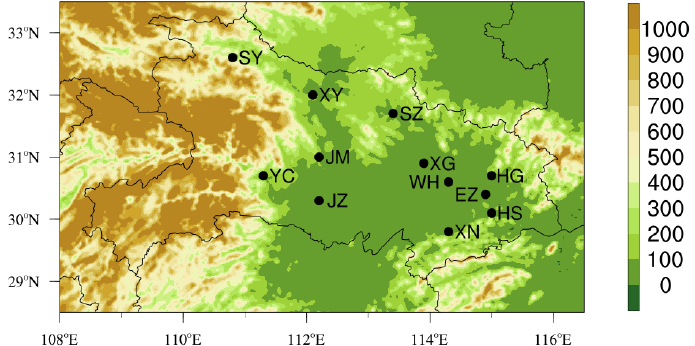
Figure 1. Terrain elevation (unit: m) and geographic locations of 12 prefectural cities in Hubei Province (WH: Wuhan; YC: Yichang; JM: Jingmen; SY: Shiyan; XY: Xiangyang; JZ: Jingzhou; SZ: Suizhou; XG: Xiaogan; HS: Huangshi; HG: Huanggang; EZ: Ezhou; XN: Xianning).